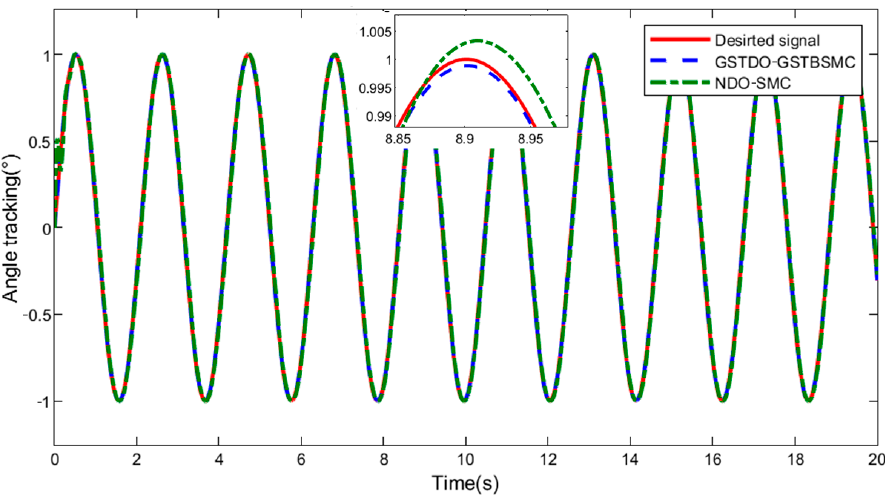
Figure 14. Comparison of the observation error of GSTDO and NDO in Experiment 2.